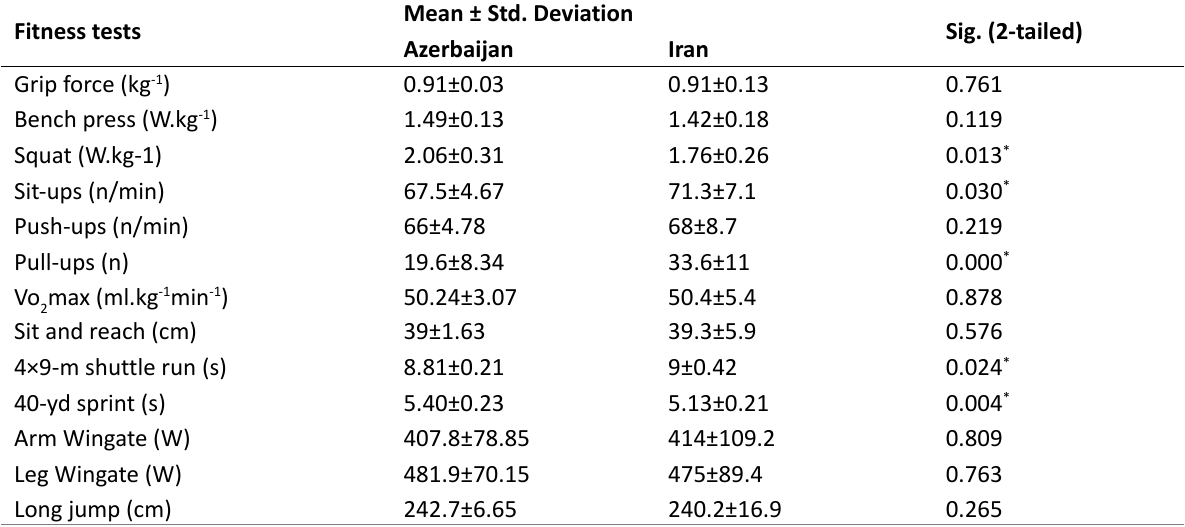
Table 2. Single-sample t-test results for comparing the fitness tests of Azerbaijan with Iran Mean ± Std. Fitness tests